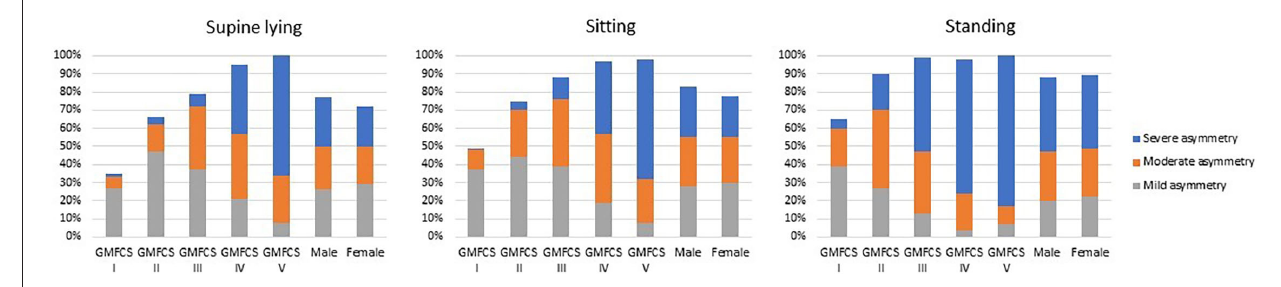
FIGURE 2 | Postural asymmetries in supine lying, sitting, and standing positions of adults by GMFCS levels and sex.